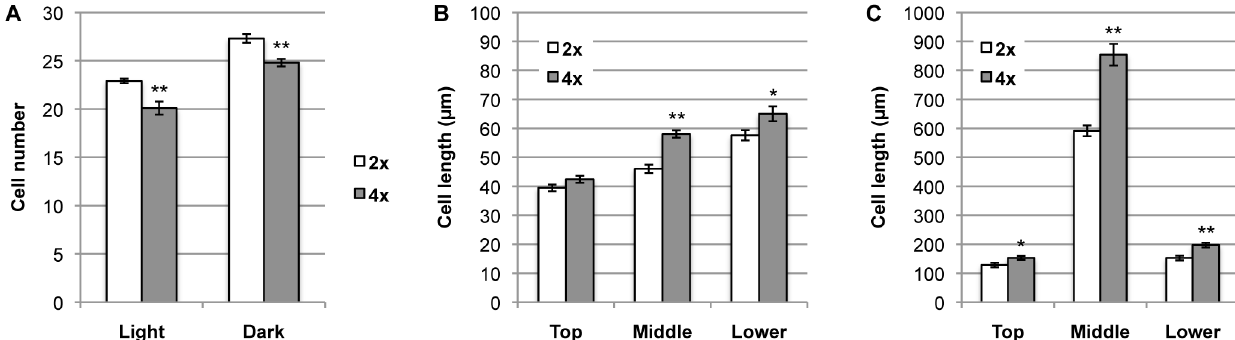
Fig 2. Cell numbers and lengths in diploid and tetraploid hypocotyls. (A) Total cell numbers for the whole hypocotyl of 5-day-old light- and dark-grown seedlings. Error bars represent SE (n = 10). (B, C) Cell lengths in top, middle, and lower hypocotyl regions of 5-day-old light- (B) and dark-grown (C) seedlings. Error bars represent SE (n = 30 cells from ten plants). Asterisks indicate a significant difference between the diploid and tetraploid plants ( ** p < 0.01, * p < 0.05, Student ’ s t -test). 2x, diploid plants; 4x, tetraploid